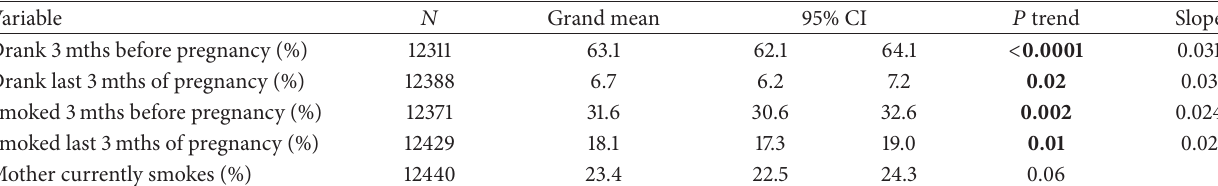
Table 3: Alcohol consumption and smoking by women giving birth in Maine, 2000–2010.